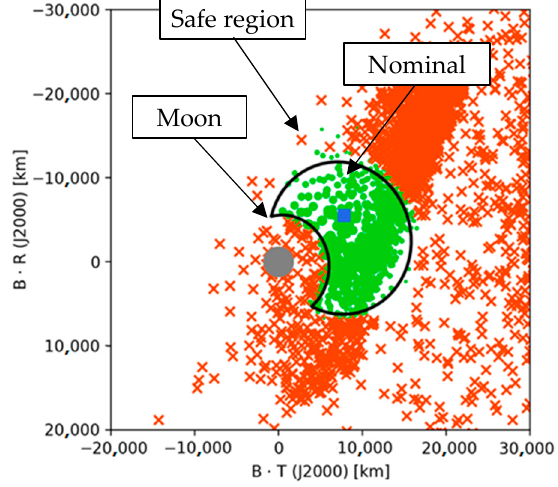
Figure 3. B-Plane [16] admissible region for the last fly-by of the Moon (M3).